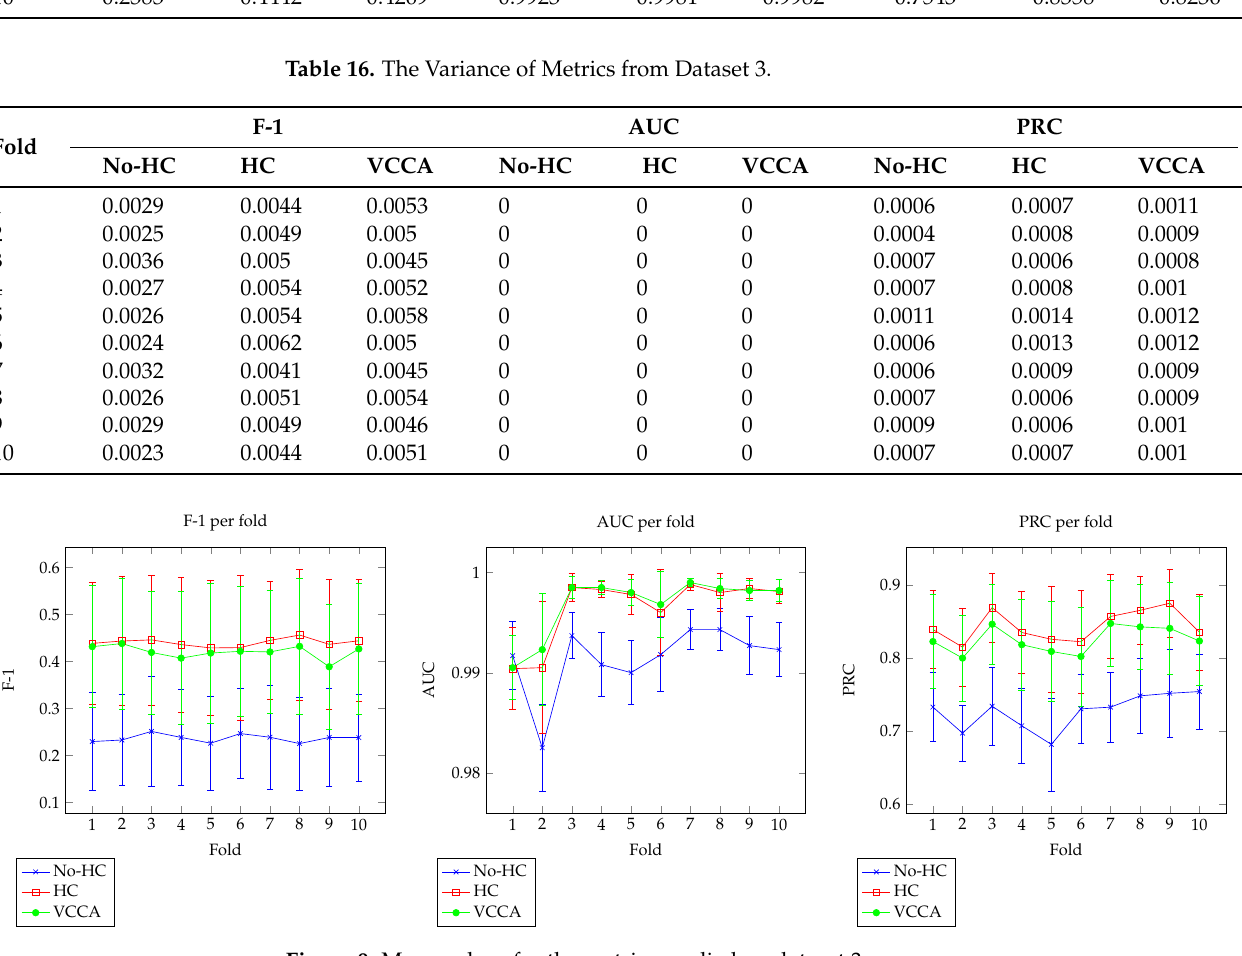
Figure 9. Mean values for the metrics applied on dataset 3. The worst training times are presented in Table 17 for each scenario and fold. Data transformation took at most 5.6 s, 20.12 s, and 21.36 s for No-HC, HC, and the